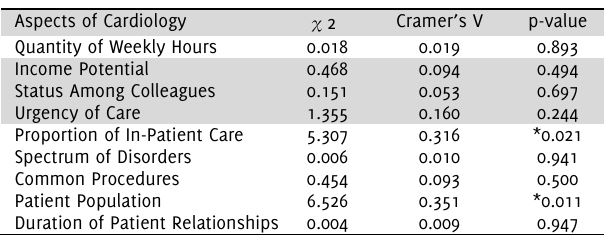
Table 5 . The Impact of Career Interest in Cardiology on Understanding of Career-Related Aspects of